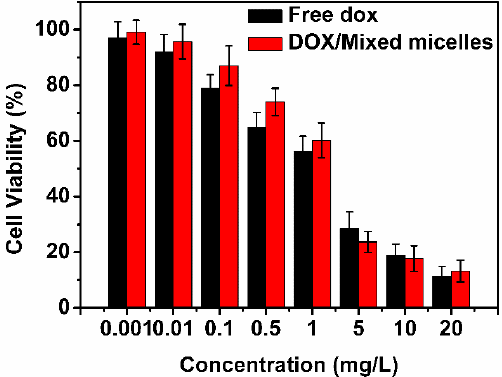
Figure 11. The in vitro cytotoxicity of blank micelles against HepG2 cells for 48 h.